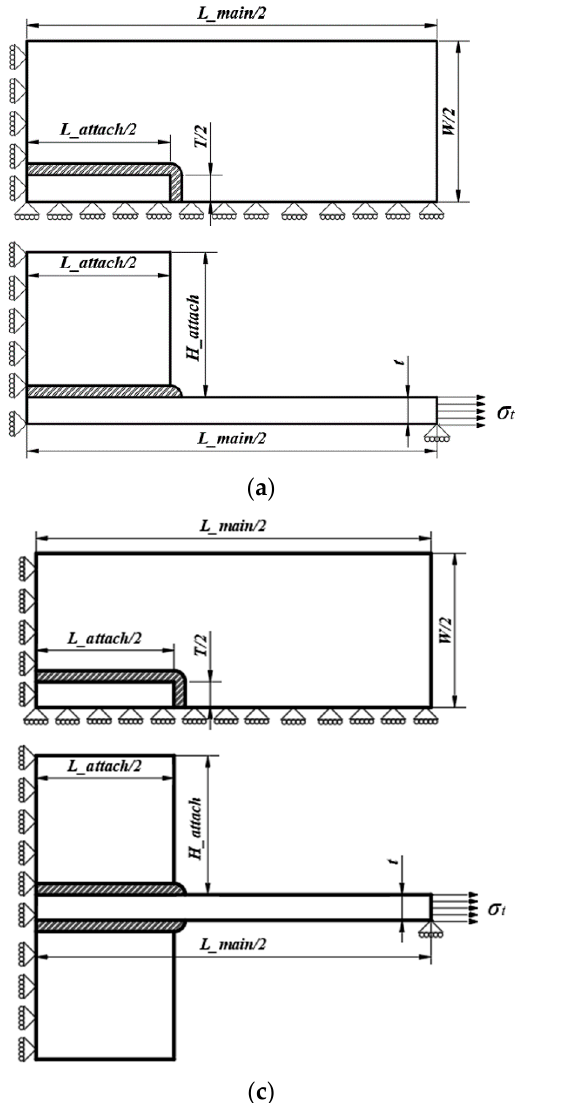
Figure 2. Loading and boundary conditions: ( a ) single attachment under tensile stress; ( b ) single attachment under bending stress; ( c ) double attachments under tensile stress; ( d ) double attachments under bending stress.